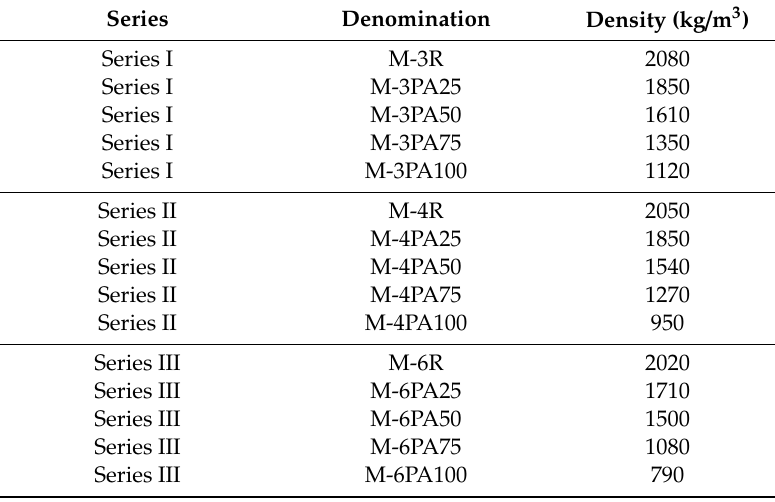
Table 8. Density values of the tested